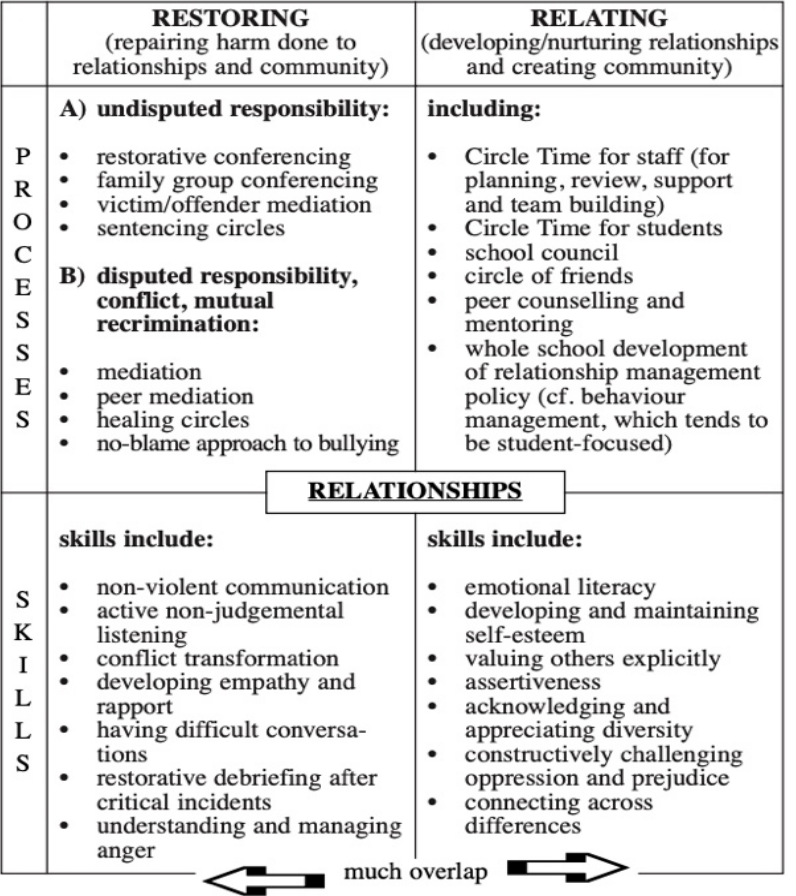
Figure 1. Restorative and relational process skills [21]. Reprinted with permission from Ref. [21]. Copyright 2021 Belinda